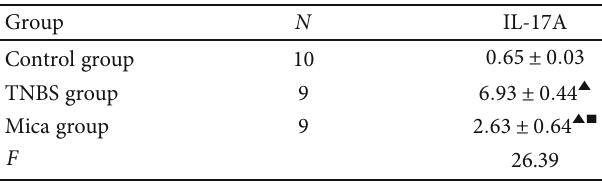
Table 8: The level of IL-17A in colon tissue ð (cid:1) x ± s, pg/ml Þ . Group